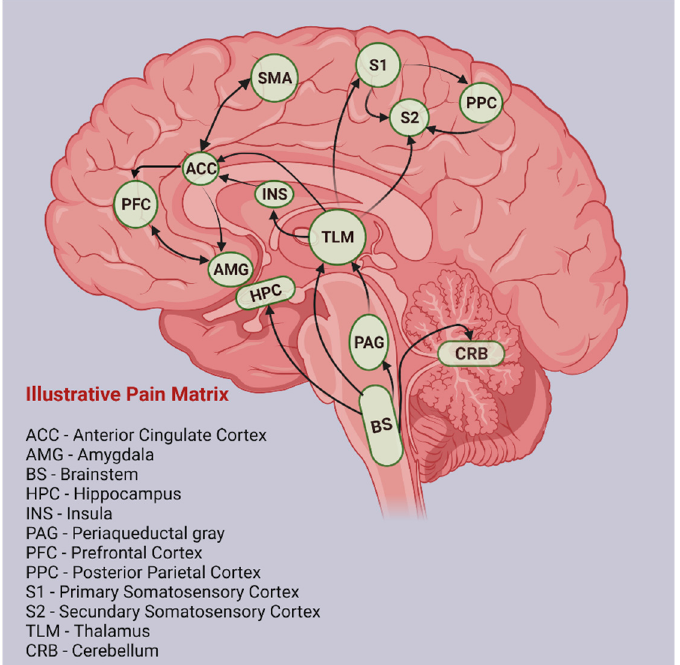
Figure 1. Illustrative pain matrix (created with BioRender.com, accessed on 15 March 2022). ACC = Anterior Cingulate Cortex; AMG = Amygdala; BS = Brainstem; HPC = Hippocampus; INS = Insula; PAG = Periaqueductal gray; PFC = Prefrontal Cortex; PPC = Posterior Parietal Cortex; S1 = Primary Somatosensory Cortex; S2 = Secundary Somatosensory Cortex; SMA = Supplementary Motor Area; TLM = Thalamus; CRB = Cerebellum.